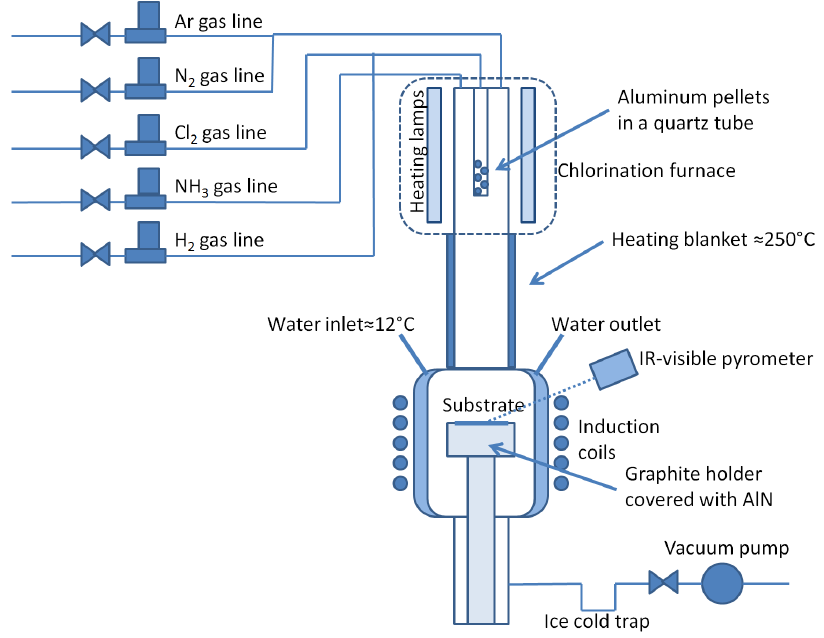
Figure 1. Vertical cold wall CVD reactor used in this study. System of valves used for pulsing is not depicted for sake of clarity.